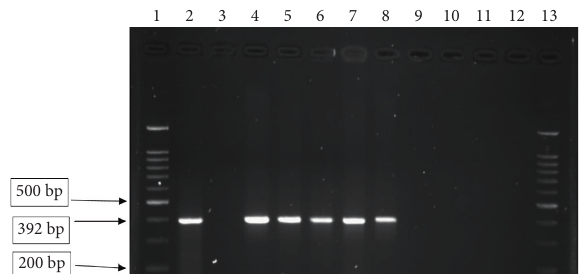
Figure 1: Electrophoresis of o qxA gene PCR product. Lanes 1 and 13, 100 bp DNA ladder; lane 2, positive control ( Klebsiella pneu- moniae ATCC 700603); lane 3, negative control ( E coli ATCC 25922); lanes 4–8, positive samples for oqxA ; lanes 9–12, negative samples.